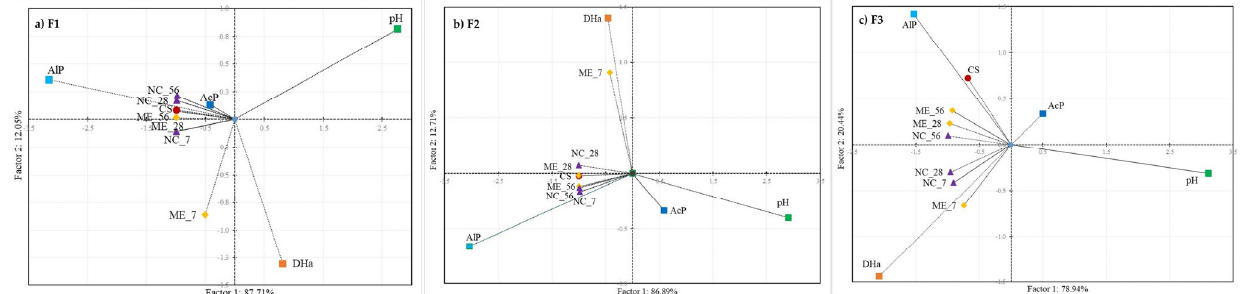
Figure 8. Principal component analysis (PCA) between dehydrogenase (DHa), acid phosphatase (AcP), alkaline phosphatase (AlP) activities, pH values and soil samples in different experimental stages: ( a ) F1; ( b ) F2; ( c ) F3. Explanation of the samples in Table 1. For F1, samples from NC after 28 and 56 days of drying (NC_28, NC_56), as well as